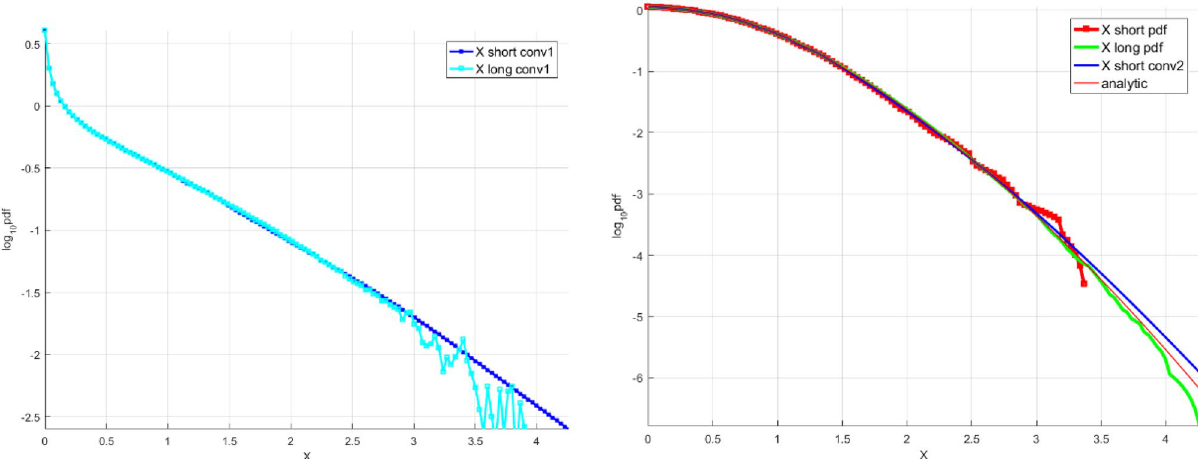
Figure 2. Synthetic wind speed data. Left: Scaled f X 1 tail on the decimal log scale for the «shorter» data (cyan squares) «longer» data (blue squares). Right: Unscaled «shorter» decimal log scale f X tail, raw (red squares) and fitted (solid blue line, along with «longer» data (green line) and analytic (solid red line).